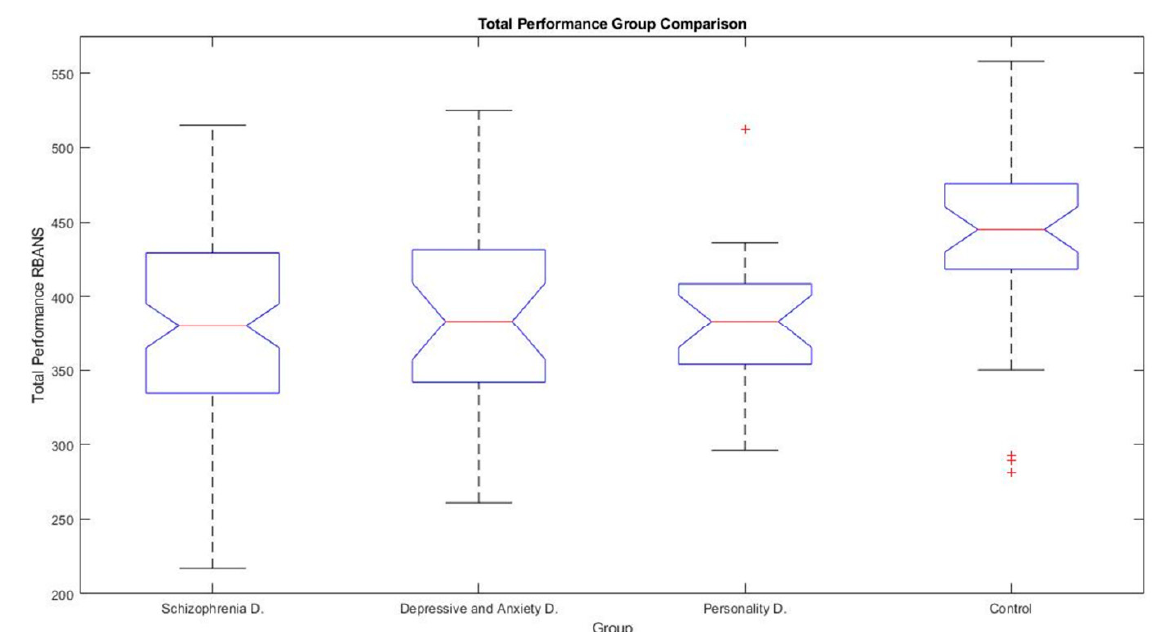
Figure 2. Boxplot showing total performance of each group in Repeatable Battery for the Assessment of Neuropsychological Status (RBANS) total score.